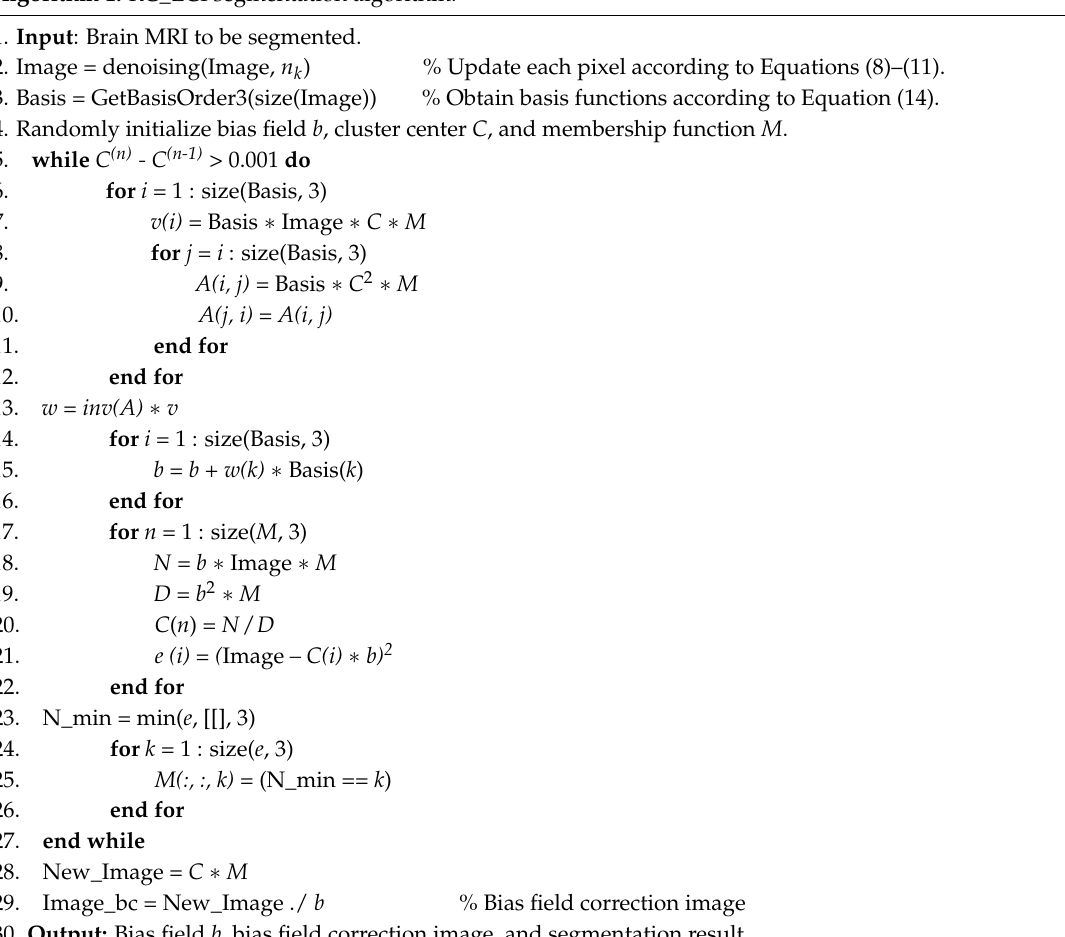
Algorithm 1. RC_LCI segmentation